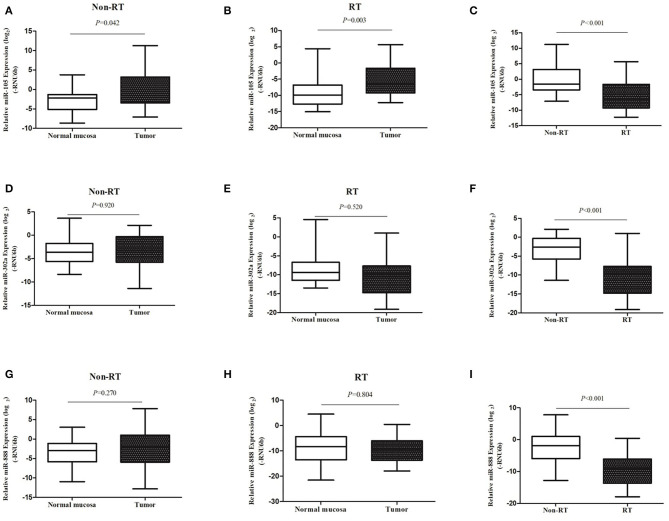
miRNA expression was examined with qRT-PCR. The expression levels of miR-105 (A–C), miR-302a (D–F), and miR-888 (G–I) in rectal cancers as compared with the normal mucosa in patients without and with RT were represented in the box–whisker plots on a log2 scale.